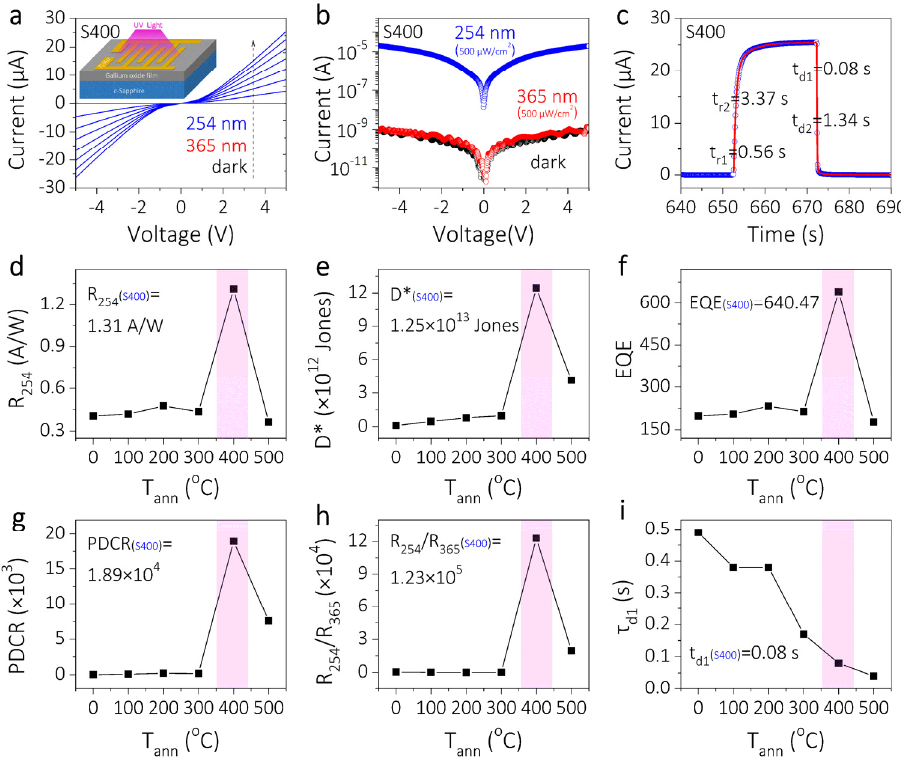
Figure 2. ( a ) I–V characteristics of mixed-phase Ga 2 O 3 PD (S400) under dark, 365 nm, and 254 nm illumination (the light intensity of 254 nm is 100–700 μ W/cm 2 , and the light intensity of 365 nm is 500 μ W/cm 2 ), and the inset shows the structure diagram of MSM structured Ga 2 O 3 PD. ( b ) I–V characteristics of S400 under dark and illumination with 254 nm/365 nm UV light (500 μ W/cm 2 ) on a logarithmic scale. ( c ) Enlarged view of the single response (blue) of S400 and the corresponding fitted rise and decay times (red). ( d – i ) Plots of R, D*, EQE, PDCR, R 254 /R 365 , and τ d1 versus postannealing temperature.